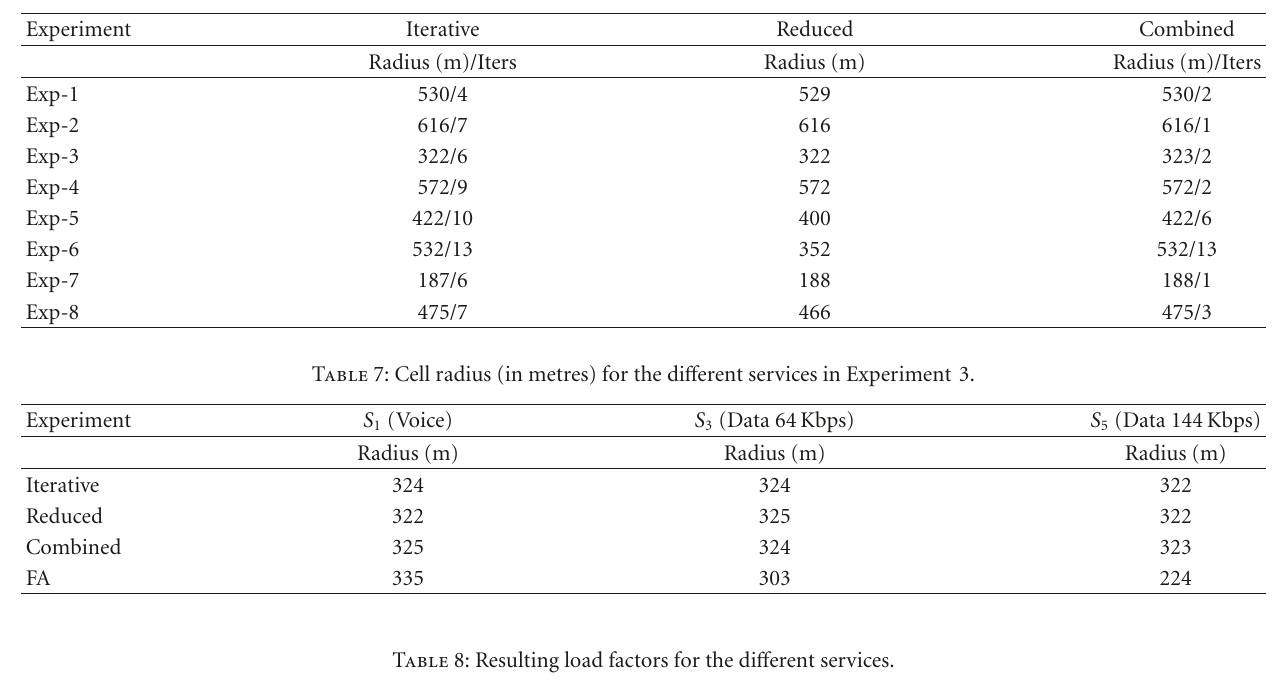
Table 6: Cell radius (in metres) for each experiment calculated using the proposed heuristics.